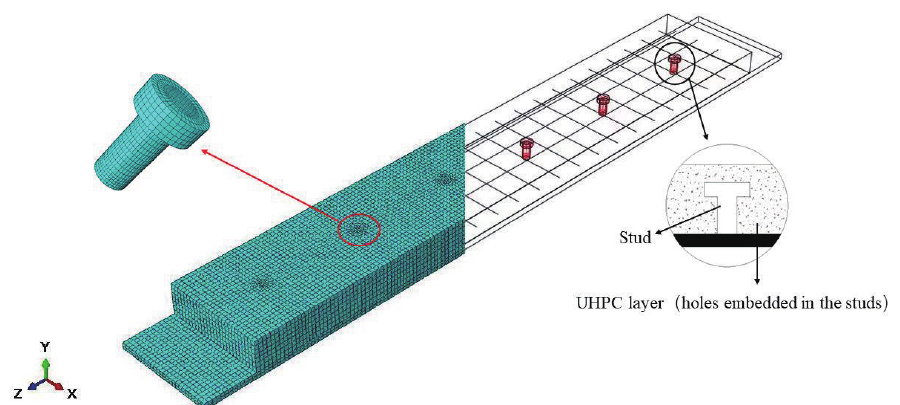
Figure 12. Meshing of composite slab finite element model and distribution of reinforcement frame and